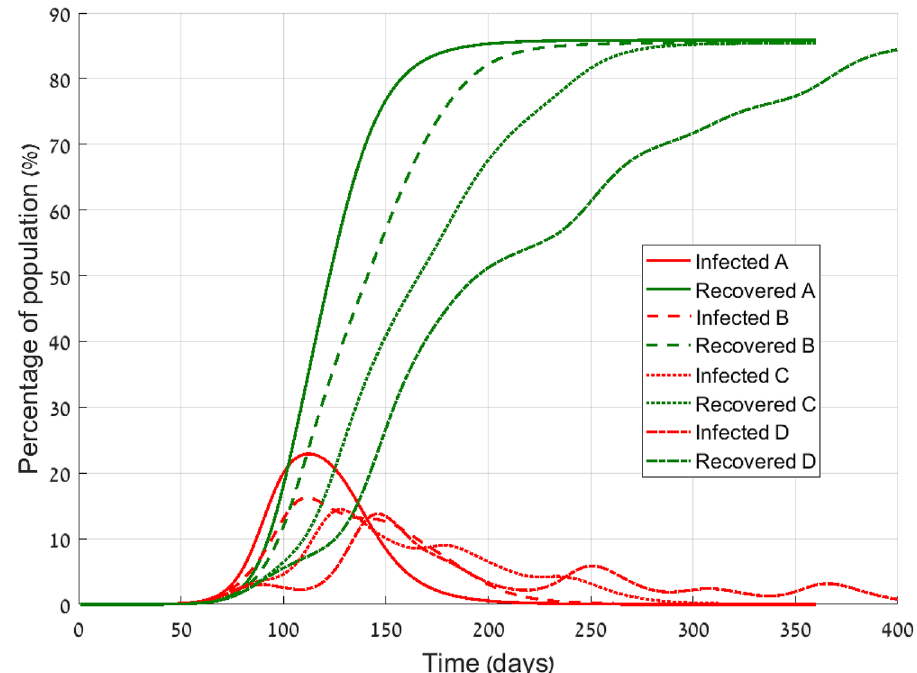
Figure 3. Morbidity and recovery with partial travel limitation starting at day 1 (DeVisscher model). A— standard commuting, B—90% travel limitation, C—99% travel limitation, D—99.9% travel limitation. Subpopulations are grouped according to Table 1 in order to make presentation equivalent to SIR model.